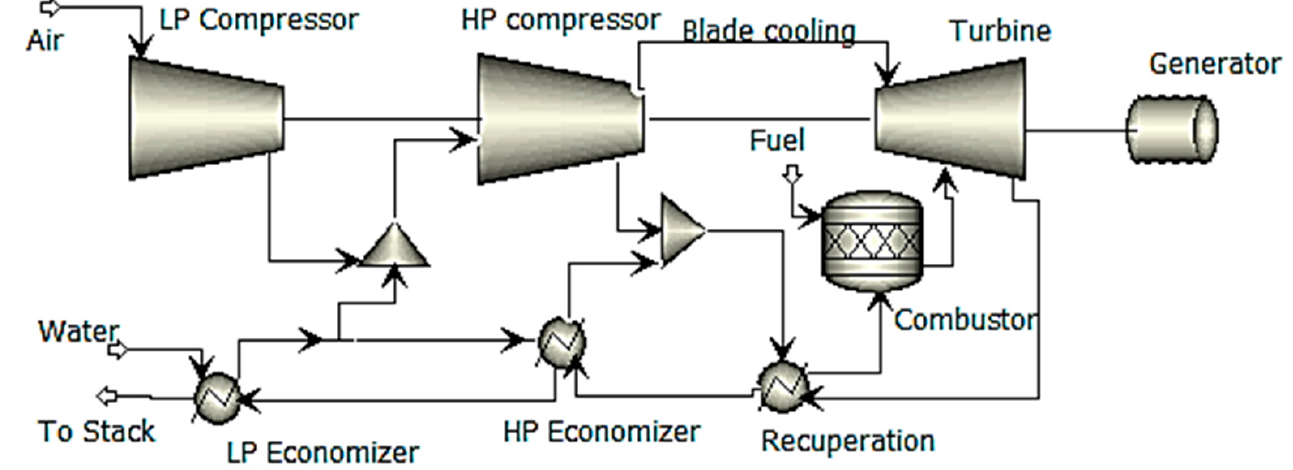
Figure 5. Conceptual plant design for cycles, including inter-cooled water injection (RWI).